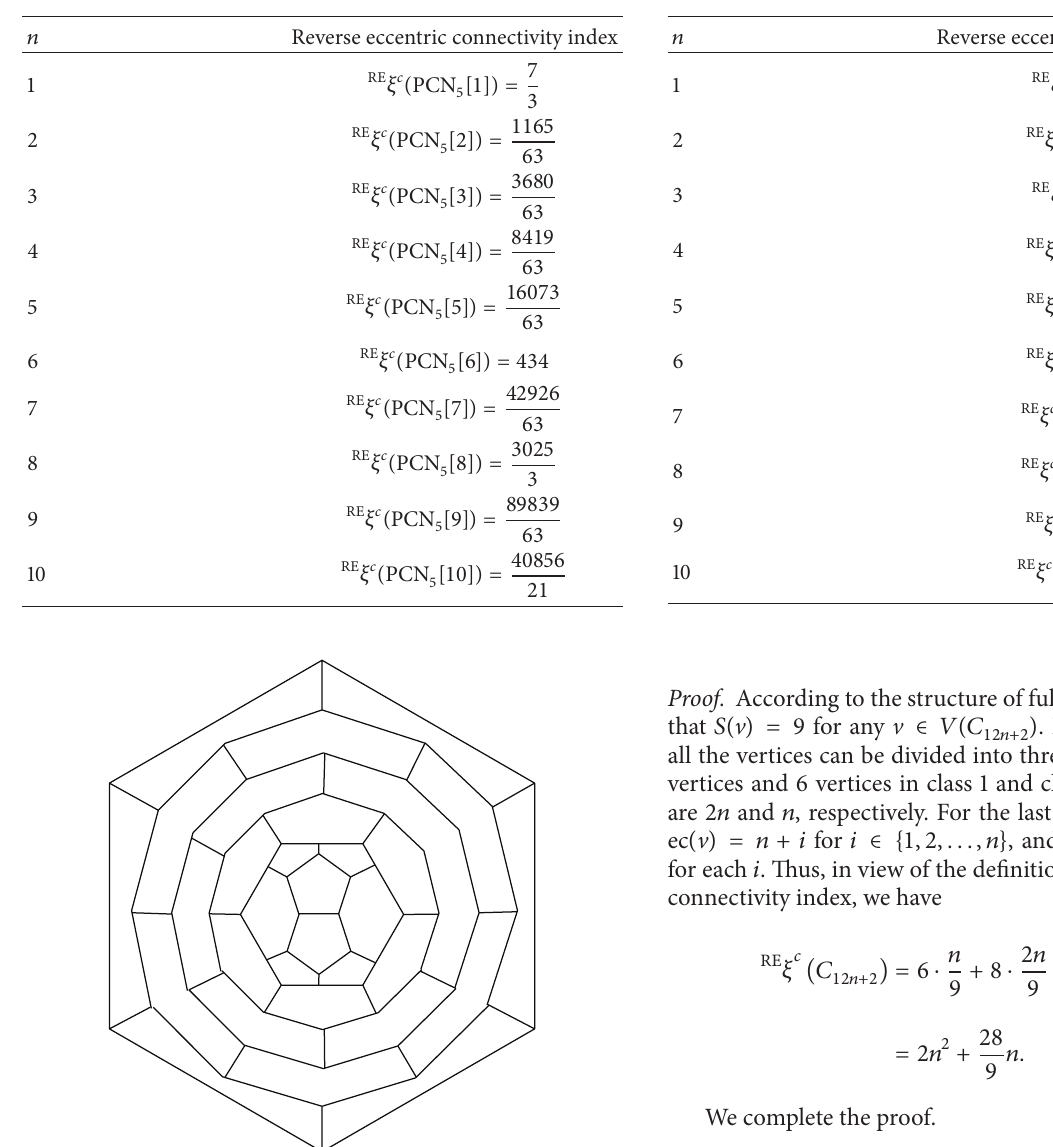
Table 2: Some exceptional cases of reverse eccentric connectivity index of fullerenes 𝐶 12𝑛+2